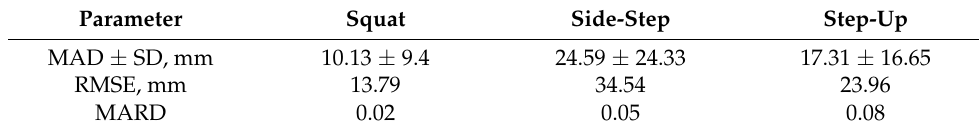
Table 5. Results of the examined exercises. Annotation: MARD = mean absolute relative difference.